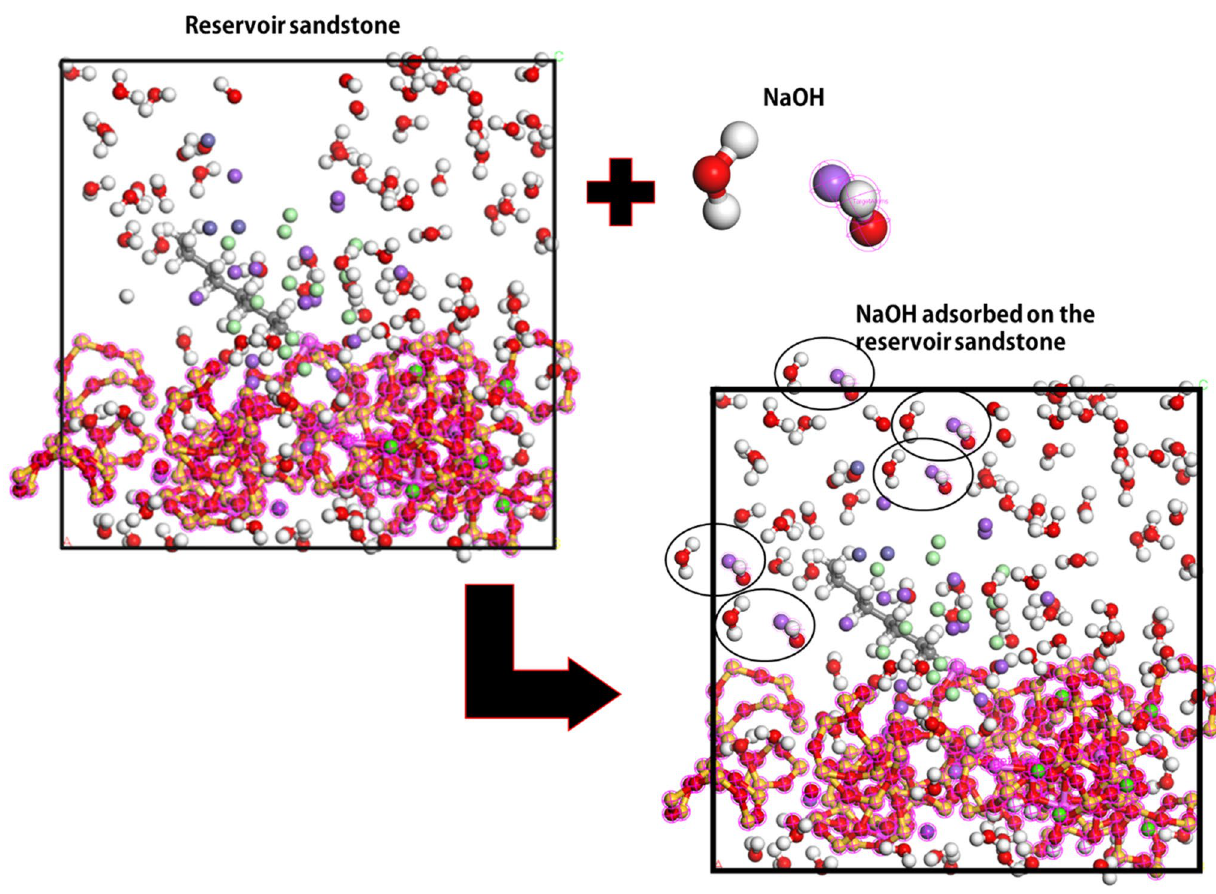
Fig. 11 Geometry of NaOH adsorption on reservoir sandstone